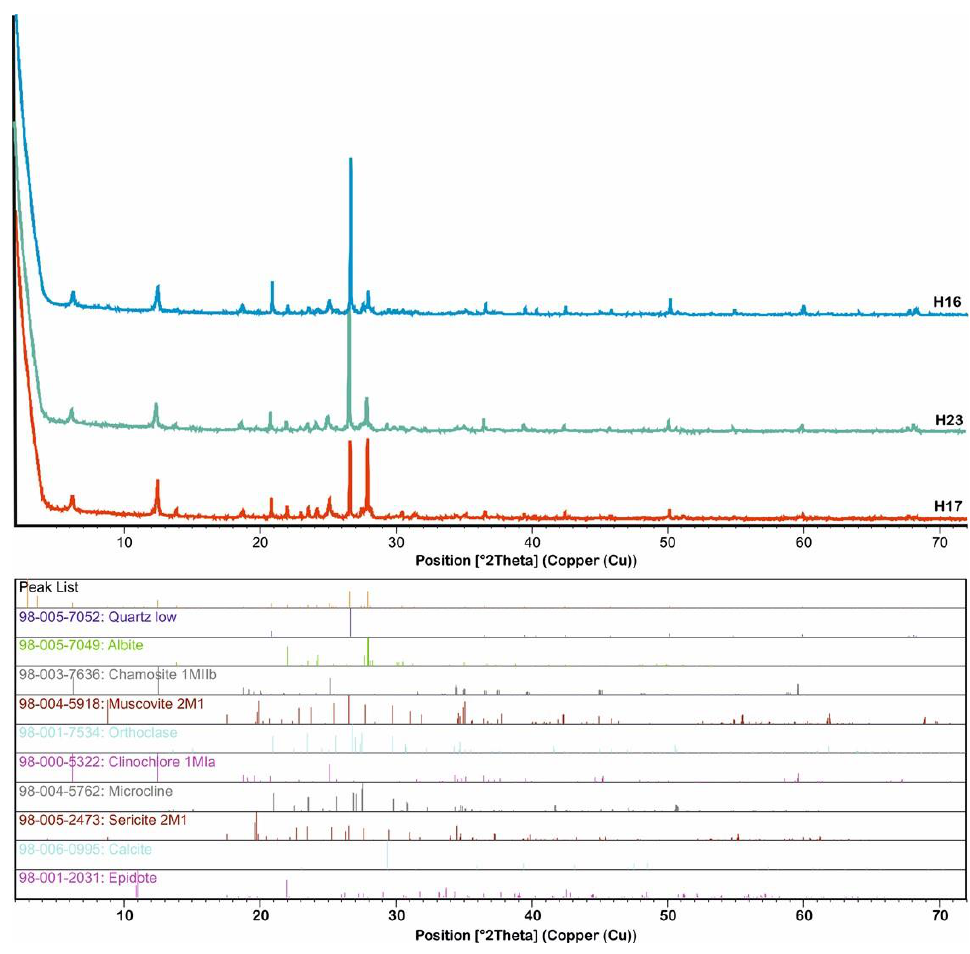
Figure 7. XRD patterns of representative samples from alteration zone-2 (calcite–epidote–albite ± chlorite ± sericite).